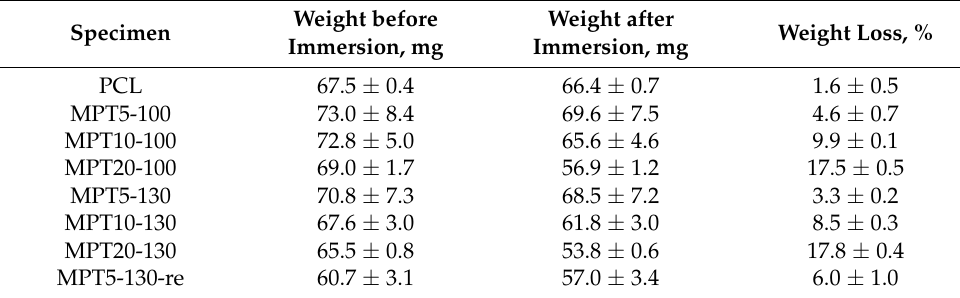
Table A2. Weight loss of PCL/MPT blends after being immersed for 35 days.